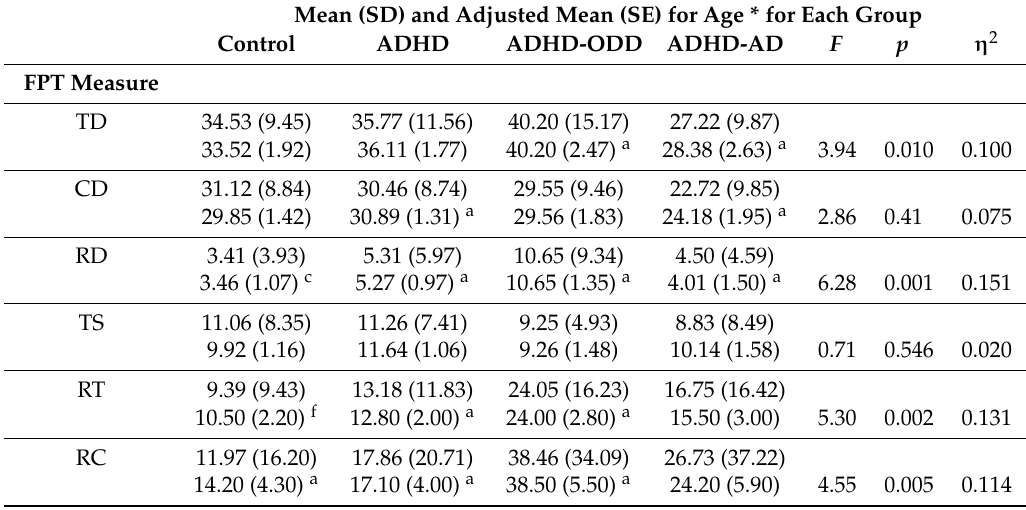
Table 3. Performance and group di ff erences across the FPT measures. Mean (SD) and Adjusted Mean (SE) for Age * for Each Group Control ADHD ADHD-ODD